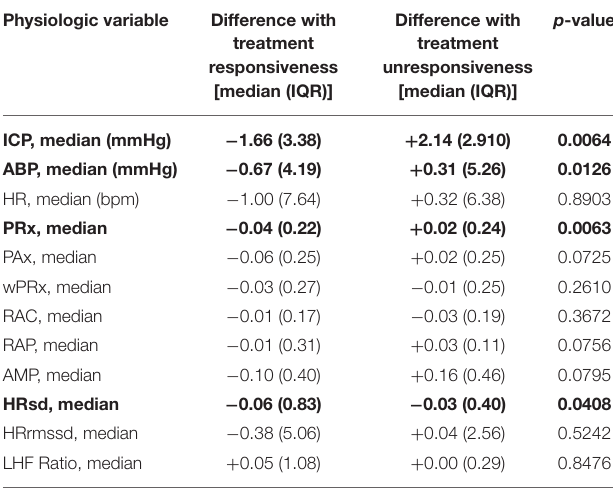
TABLE 3 | Differences in cerebral physiology to bolus hyperosmolar therapy after intracranial hypertension. Physiologic variable Difference with